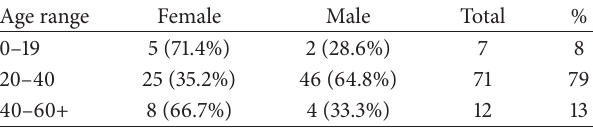
Table 1: Age-sex distribution of respondents ( 𝑛 = 90 ).